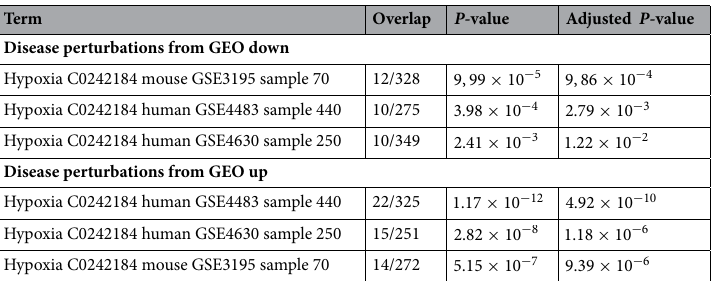
Table 5. “Disease Perturbations from GEO down/up” category of Enrichr for 196 genes selected by applying TD-based unsupervised FE to m6A profiles. Six hypoxia experiments with adjusted P -values less than 0.05 are listed.